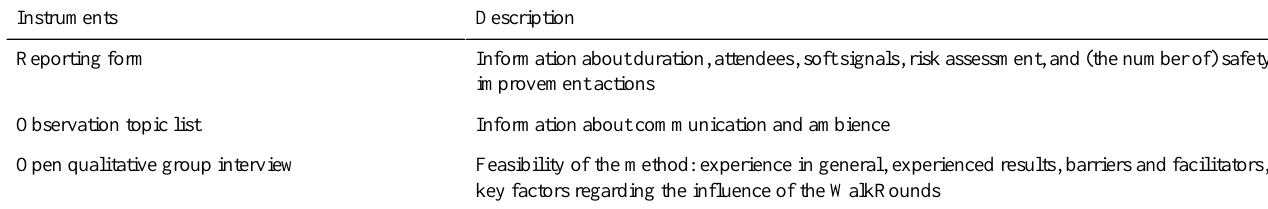
Table 4. Data instruments for WalkRounds.